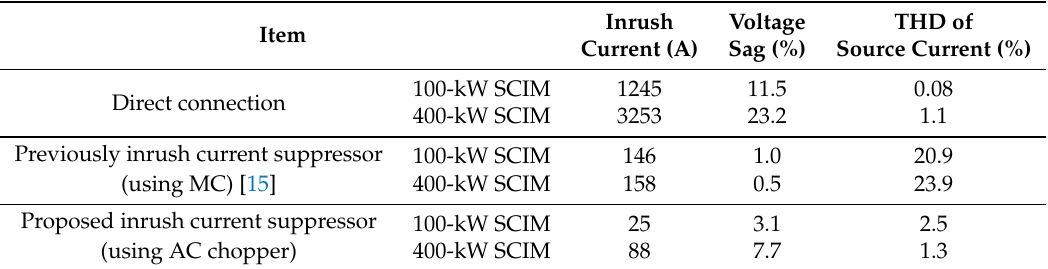
Figure 13. Simulation waveforms for 2 s when the proposed inrush current suppressor is connected to the 400-kW SCIM. Table 3. Comparative analysis. THD, total harmonic distortion; MC, matrix converter.